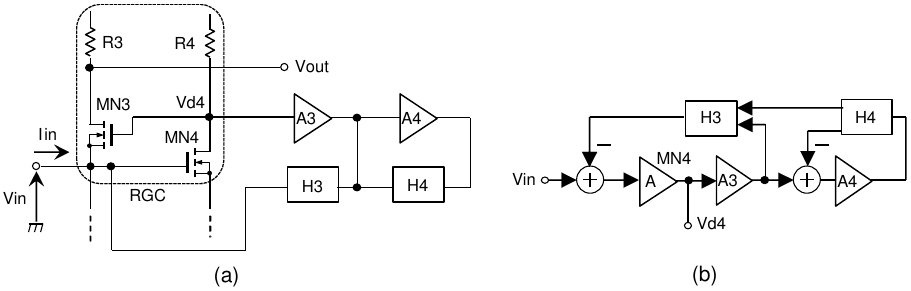
Figure 5. Proposed TIA block diagram. ( a ) A part of RGC and multi-feedback stage. ( b ) Block diagram for transfer function